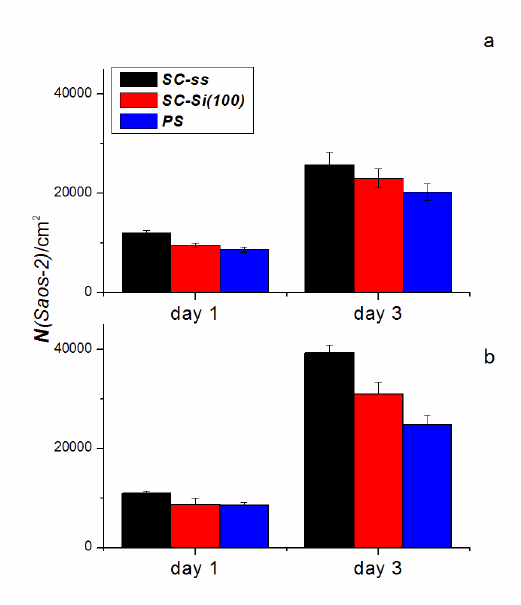
Figure 4. Comparison of the N(Saos-2) on days 1 and 3 after seeding on the surfaces of the samples SC-SS , SC-Si(100) and PS before (a) and after heat treatment (b) of the samples at 300